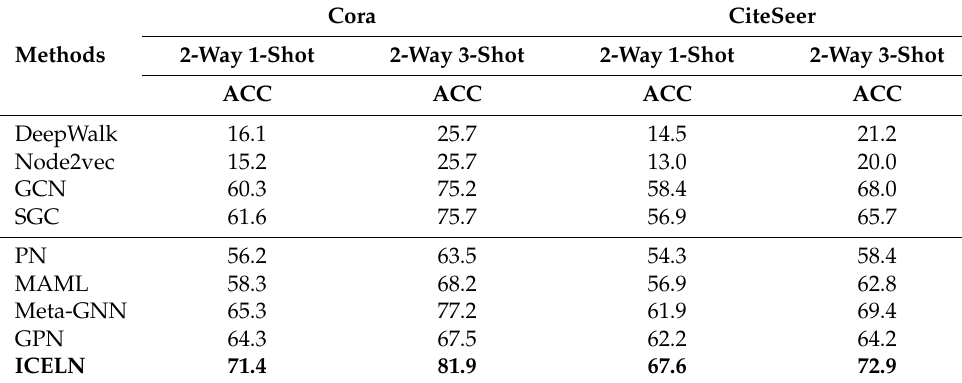
Table 2. The few-shot node classification ACC results on Cora and CiteSeer.